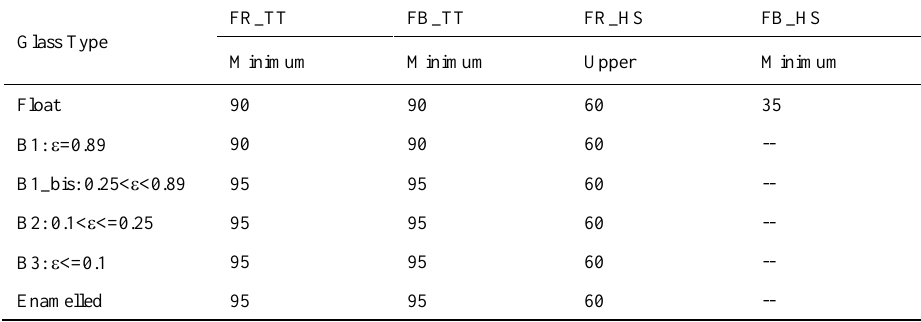
Table 11. Suggested SC value (MPa) respect FR and FB according SSV testing on